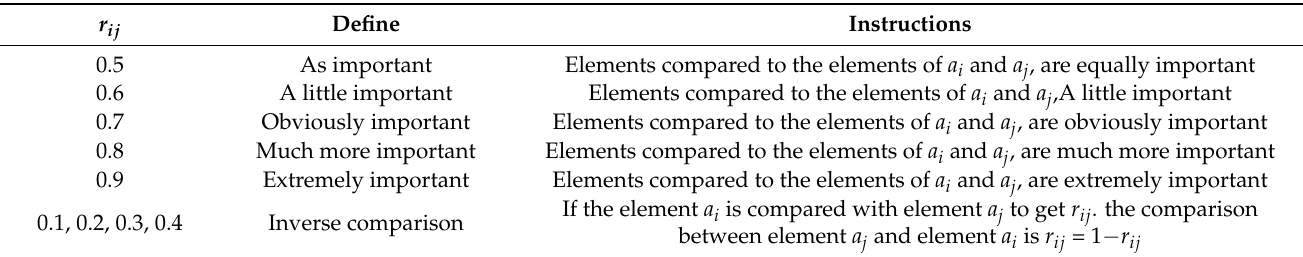
Table 2. The importance scale of indicator